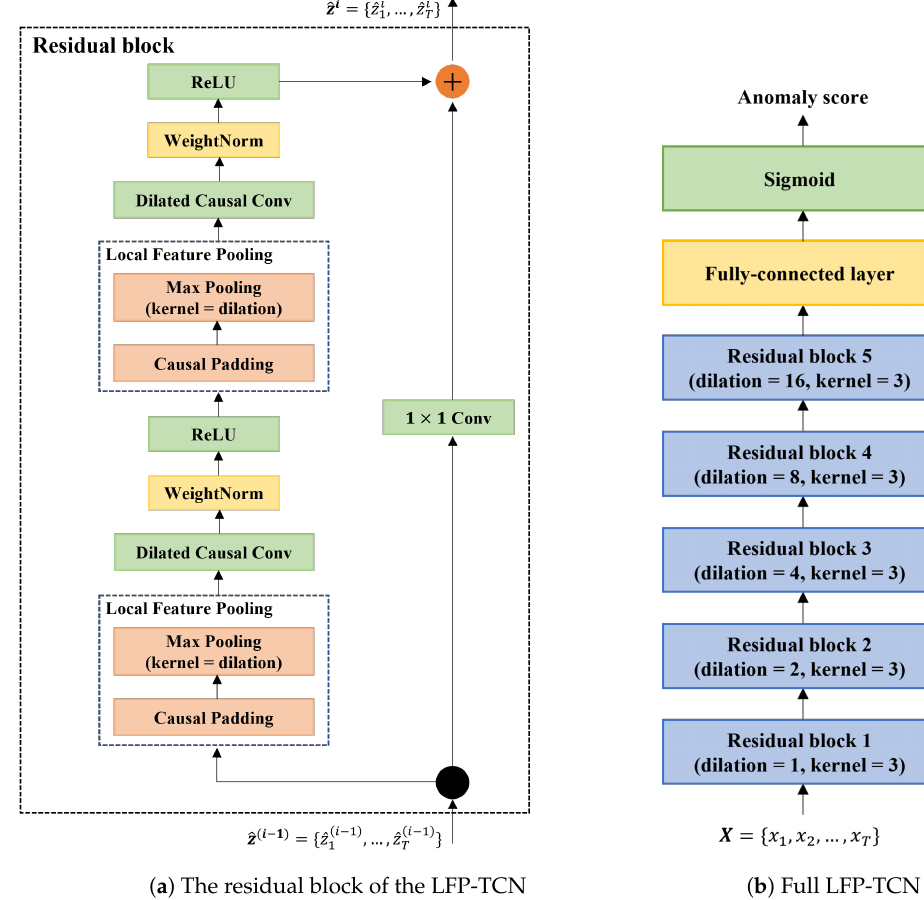
Figure 3. ( a ) The LFP modules are added in front of the dilated causal convolution layers. They aggregate local information of inputs and pass compressed feature information to the convolution layers. ( b ) Full LFP-TCN consists of 5 stacked residual blocks and a fully connected